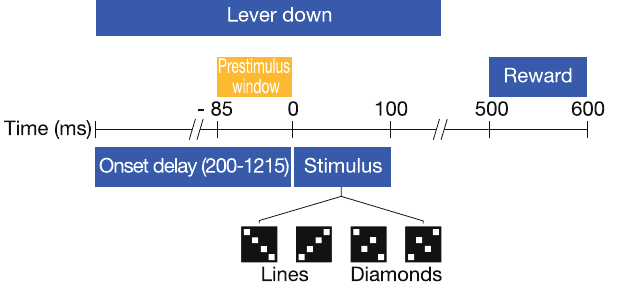
Figure 1. Task Structure. Task components of a Go trial. No-go trials followed the same event time course, except that for no-go trials the lever press was maintained throughout the trial, and there was no